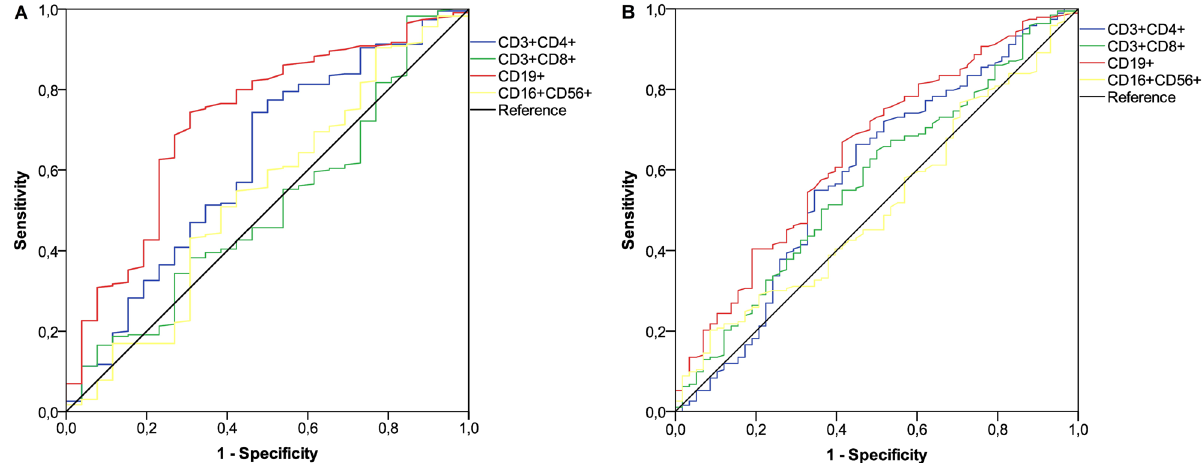
Figure 2. ROC curve analysis. Receiver operating characteristic (ROC) curves are represented for subsets of peripheral lymphocytes. ( A ) ROC analysis showing the performance of absolute counts of peripheral lymphocyte subsets in distinguishing positive seroconversion responses at timepoint-1. AUC for the subpopulation relative values: T helper cells (CD3 + CD4 +): 0.62 (95% CI 0.49–0.74; P = 0.044); T cytotoxic cells (CD3 + CD8 +): 0.50 (95% CI 0.39–0.62; P = 0.89); B cells (CD19 +): 0.72 (95% CI 0.61–0.83; P < 0.041); NK cells (CD16 + CD56 +): 0.53 (95% CI 0.41–0.66; P = 0.52). ( B ) ROC analysis showing the performance of absolute counts of peripheral lymphocyte subsets in distinguishing 50% vaccine efficacy rates at timepoint-2; AUC for the subpopulation relative values: T helper cells (CD3 + CD4 +): 0.58 (95% CI 0.49–0.67; P = 0.05); T cytotoxic cells (CD3 + CD8 +): 0.57 (95% CI 0.48–0.65; P = 0.09); B cells (CD19 +): 0.64 (95% CI 0.56–0.72; P = 0.001); NK cells (CD16 + CD56 +): 0.51 (95% CI 0.42–0.59; P = 0.79). AUC, area under the curve; NK, Natural Killer; CI, confidence interval. Timepoint-1 denotes assessment before the third dose of tozinameran; timepoint-2 denotes assessment four weeks after the third dose of tozinameran; an antibody titer ≥ 50 AU/mL indicates a positive seroconversion response; antibody titer ≥ 4446 AU/ml was associated with 50% vaccine efficacy against a symptomatic COVID-19